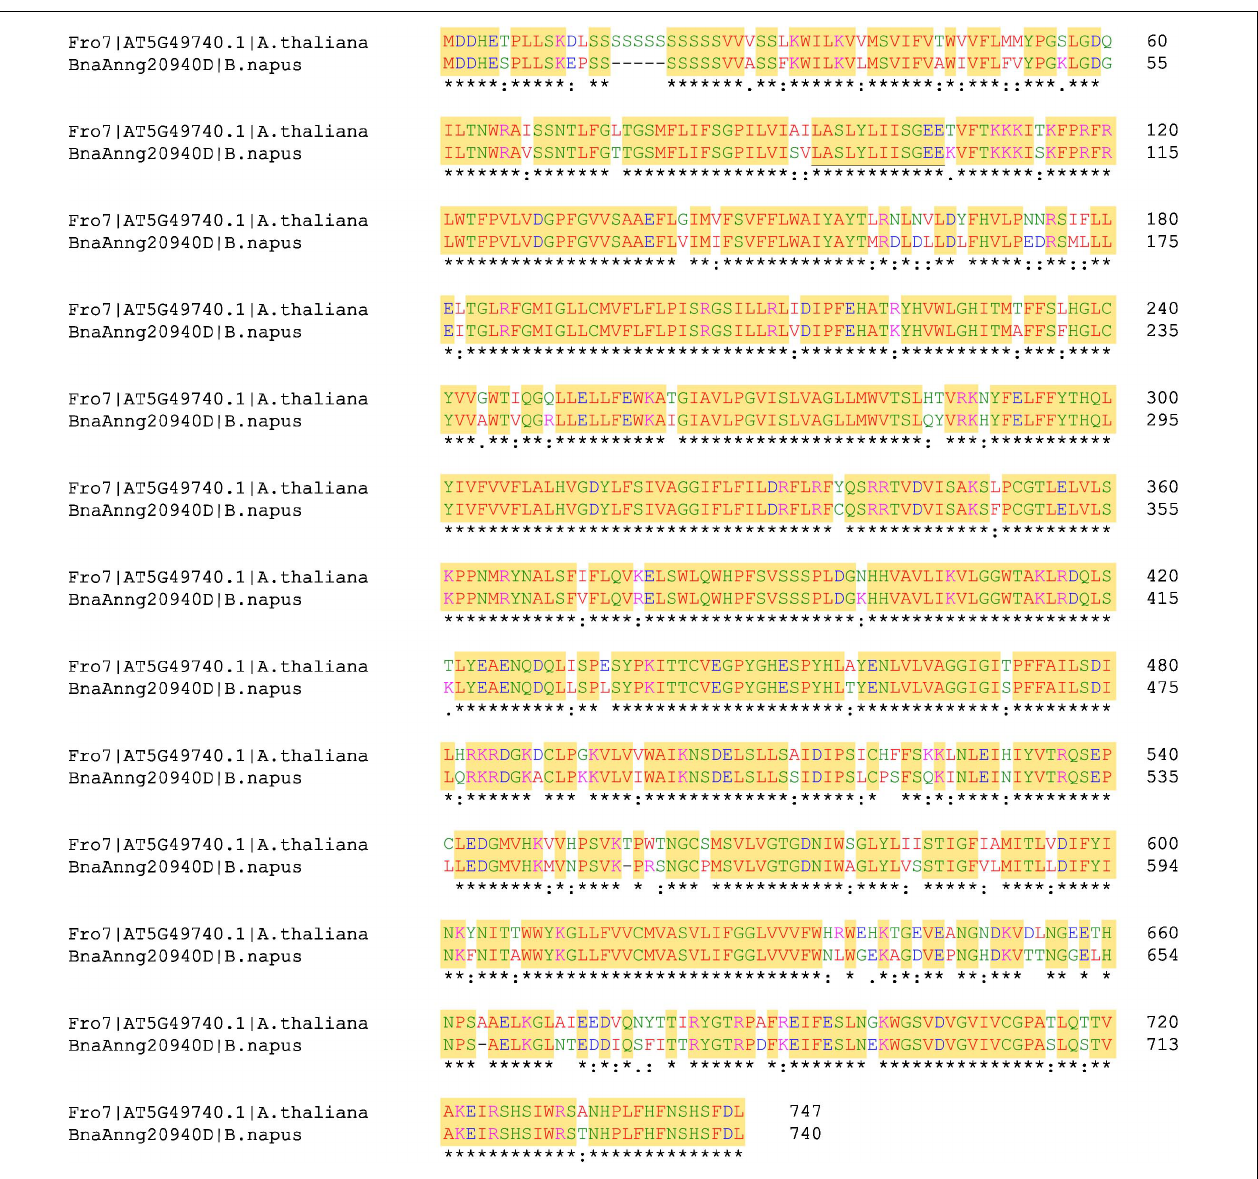
FIGURE 6 | Protein sequence alignment of Arabidopsis thaliana FRO7 on the predicted Brassica napus FRO7. Yellow highlights indicate identical amino acid positions. Asterisks indicate identical amino acids; colons indicate conservation between groups of strongly similar properties; dots indicate conservation between groups of weakly similar properties. Colour coding of the amino acids: red [small + hydrophobic (including F)], blue (acidic), magenta (alkaline + H) and green (hydroxyl + sulfhydryl + amine +